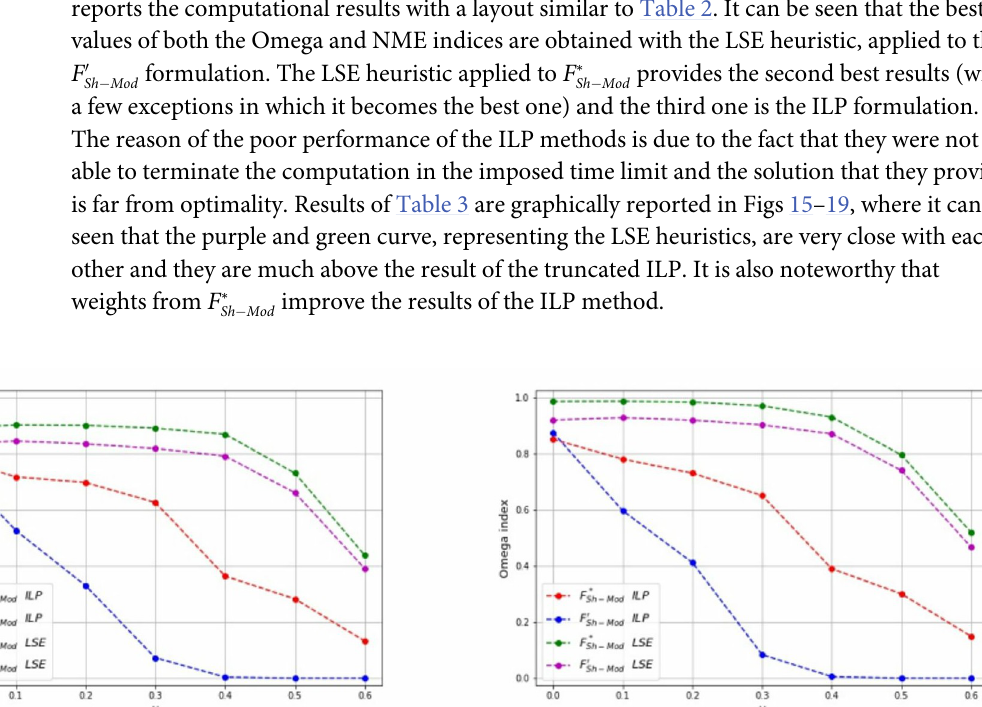
= 6. (a) Average NMI for each solution method, (b) Average c